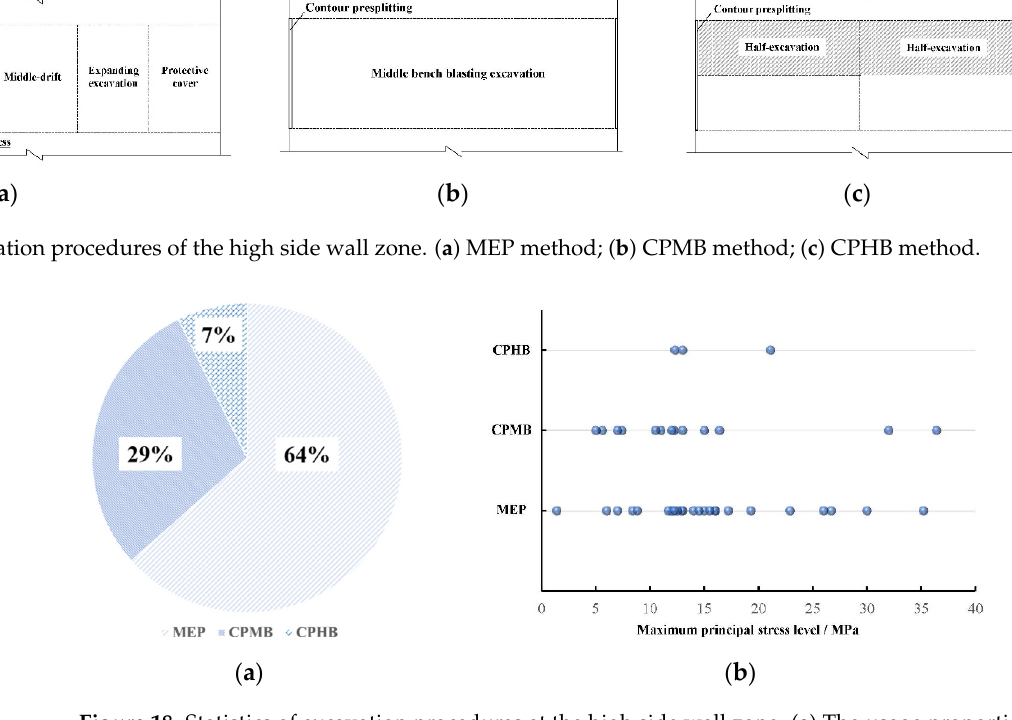
Figure 18. Statistics of excavation procedures at the high side wall zone. ( a ) The usage proportion of excavation procedures. ( b ) In situ stress distribution of excavation procedures.